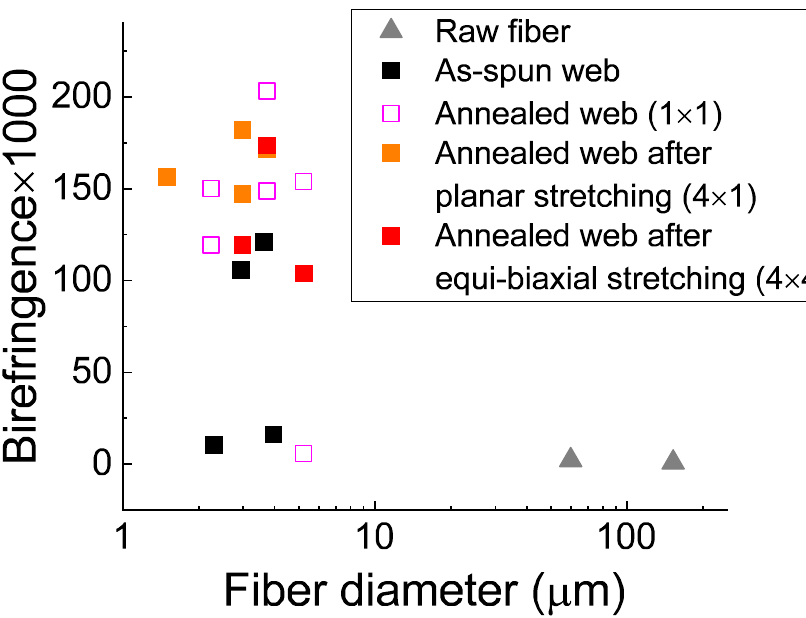
Figure 5. Correlation between fiber diameter and birefringence of a raw fiber and fibers in the web samples of various processing conditions.